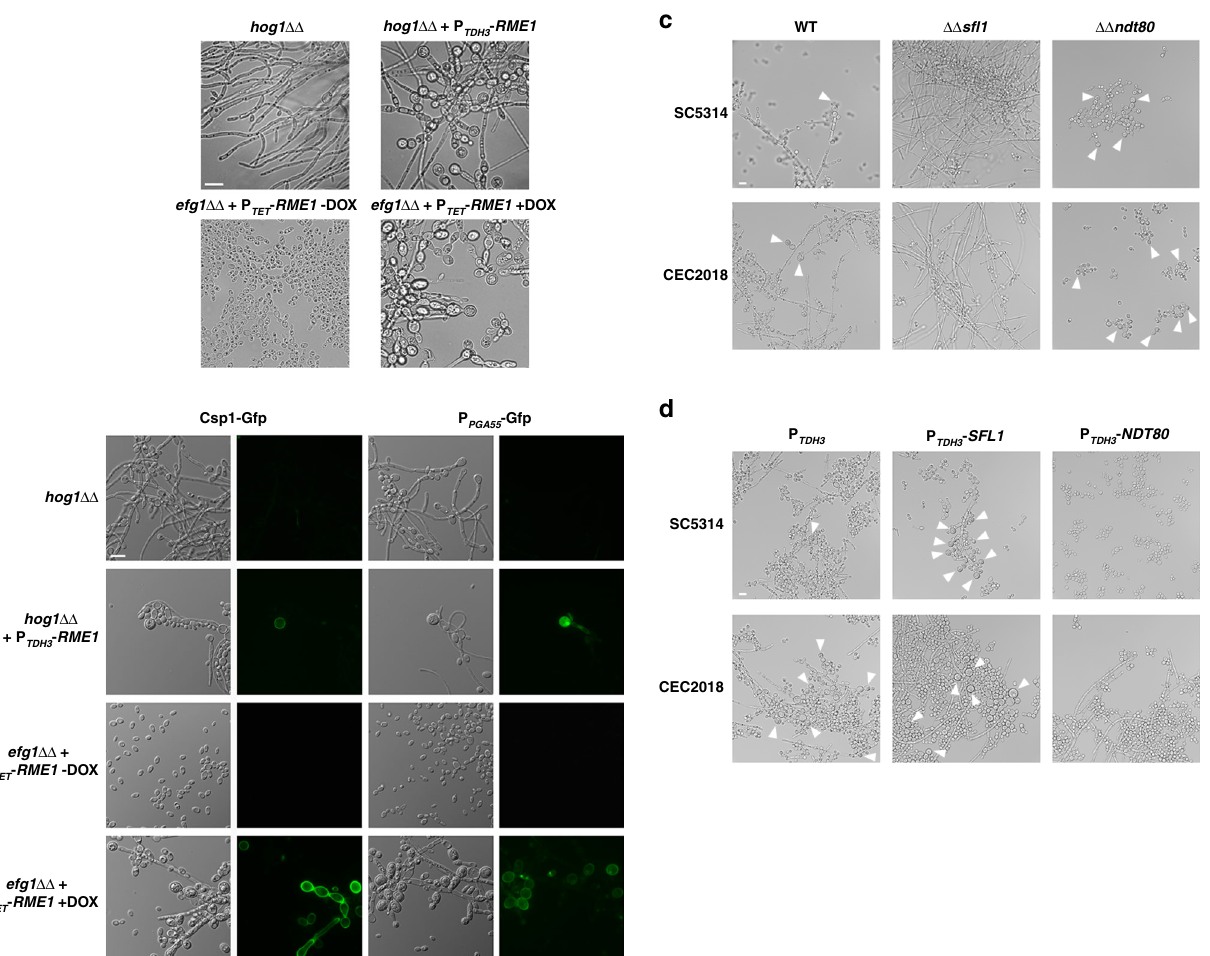
Fig. 6 Regulators of morphogenesis in fl uence chlamydosporulation through Rme1. a C. albicans hog1 ΔΔ and efg1 ΔΔ mutant strains expressing P TDH3 - RME1 and P TET - RME1 respectively were grown during 3 days under chlamydospore-inducing conditions on PCB plates, b the same cells recovered from cellophane fi lm on PCB plates expressing either the CSP1 - GFP (left) or P PGA55 - GFP (right) fusions. The cultures were inspected by phase contrast and fl uorescence microscopy. Doxycycline was added when needed to a fi nal concentration of 40 μ g/mL. Scale bar = 10 μ m. c C. albicans s fl 1 ΔΔ and ndt80 ΔΔ mutant strains in both SC5314 (CEC5288 and CEC5290, respectively, top panels) or CEC2018 (CEC5284 and CEC5286, respectively, bottom panels) backgrounds were grown overnight in liquid chlamydospore-inducing conditions. Scale bar = 10 μ m. d Strains constitutively overexpressing either SFL1 (middle panels) or NDT80 (right panels) in the WT backgrounds of SC5314 (CEC5278 and CEC5280, respectively, top) or CEC2018 (CEC5274 and CEC5276, respectively, bottom) cultured overnight in liquid chlamydospore-inducing conditions; SC5314 and CEC2018 transformed with the empty overexpression plasmid (CEC5393 and CEC5292, respectively) were used as controls (left panels). Strains were examined by light microscopy for their ability to form chlamydospores (white arrowheads in ( c ) and ( d )). Scale bar = 10 μ